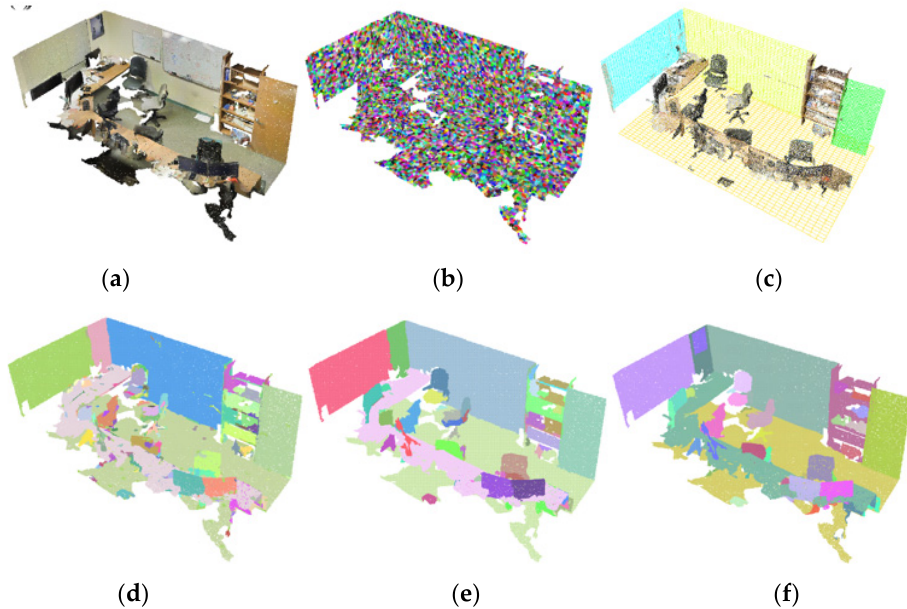
Figure 5. The segmentation result of office-1. ( a ) Raw point clouds ( b ) The generated surface patches. ( c ) The extracted indoor structural planes set and leftover points of the scene. ( d ) The indoor segmentations after multi-constraint graph clustering. ( e ) The final segmentation result after post-refinement. ( f ) The ground truth.